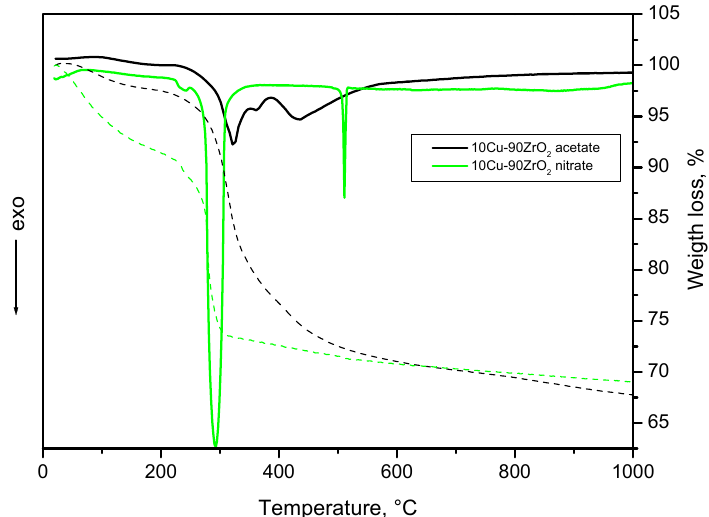
Figure 10. Differential thermal analysis (DTA) (solid line)–thermogravimetric (TG) (dot line) curves of the dried 10Cu–90ZrO 2 where acetylacetone was tested as chelating agent and copper nitrate as copper precursors (green curves), and 10Cu–90ZrO 2 obtained by using acetic acid glacial and copper acetate (black curves). Adapted with permission from [105]; Copyright 2010 Elsevier. Adapted with permission from [106]; Copyright 2011 Elsevier.